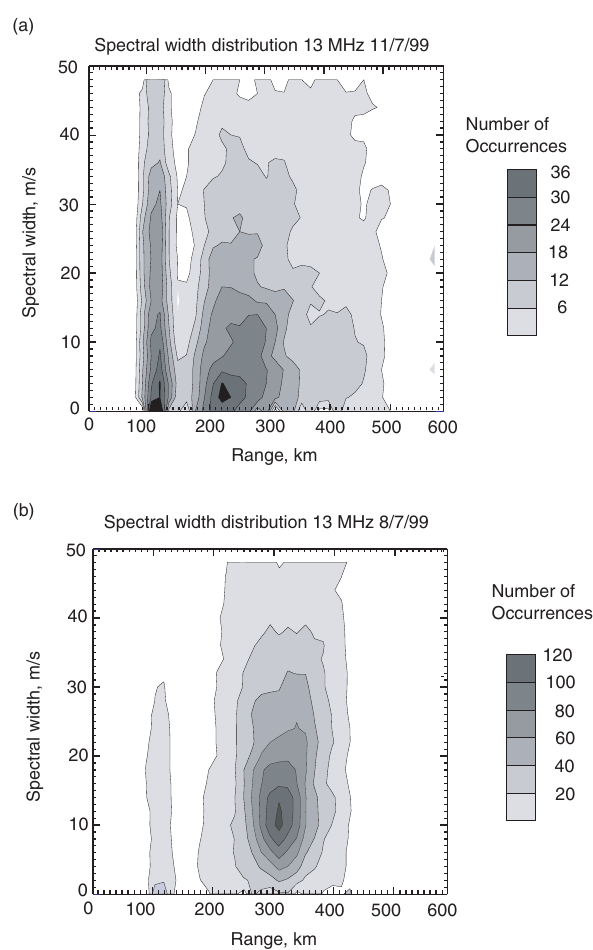
Fig. 5. Spectral width vs. range for the nearest range gates at 13MHz using a high resolution meteor mode for the Hankasalmi HF radar (a) 11 July 1999 (b) 8 July 1999. Note the change in scales to reflect the differing occurrence distributions on each